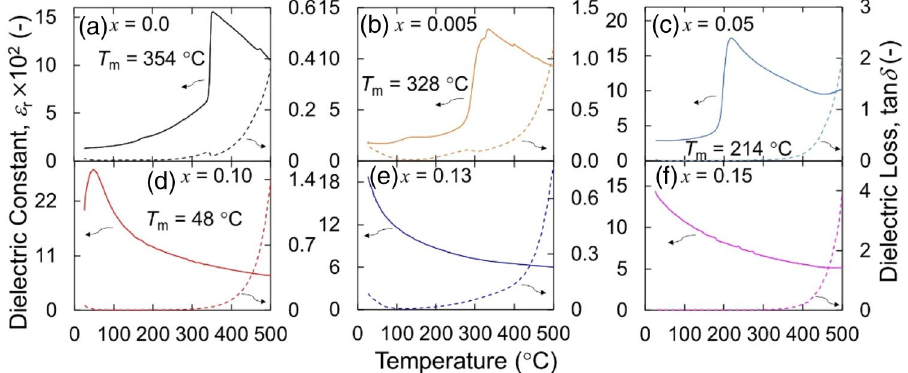
Figure 4. Temperature dependence of the relative dielectric permittivity ( ε r ) and loss (tan δ ) of the Ca-modified samples at 1 kHz: ( a ) x = 0, ( b ) x = 0.005, ( c ) x = 0.05, ( d ) x = 0.10, ( e ) x = 0.13, and ( f ) x =